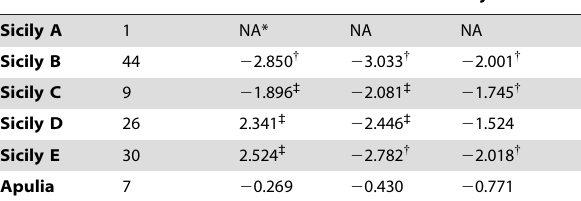
Table 3. Neutrality tests of p20 gene of CTV isolates from Italy corresponding to different introductions.